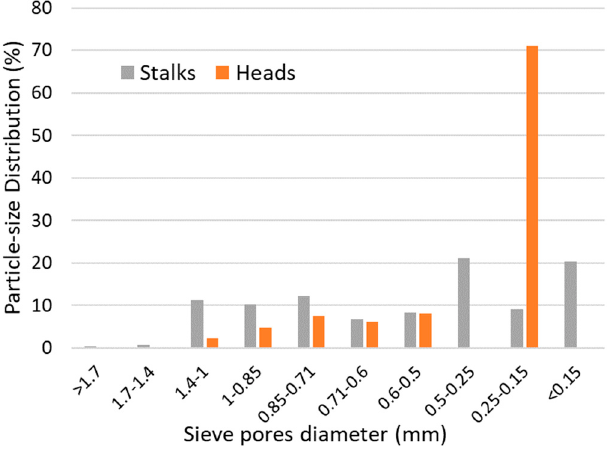
Figure 4. Graphical presentation of particle-size distribution of milled stalks and heads after sieving.